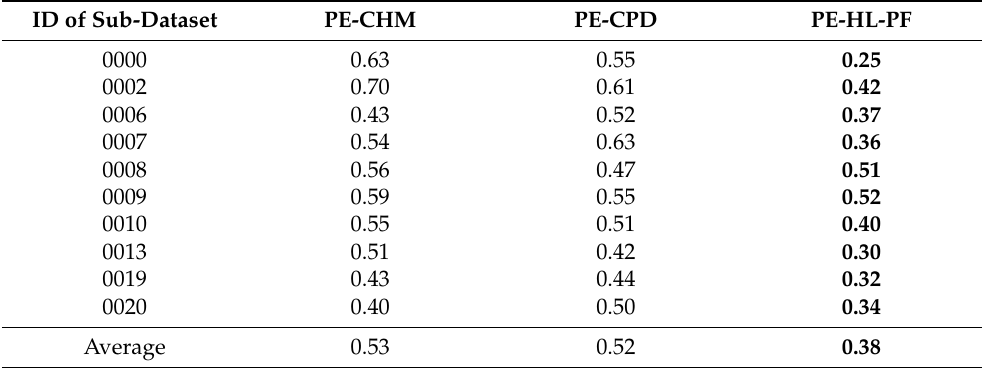
Table 3. Comparison of the mean position errors with ground truth object (meter). ID of